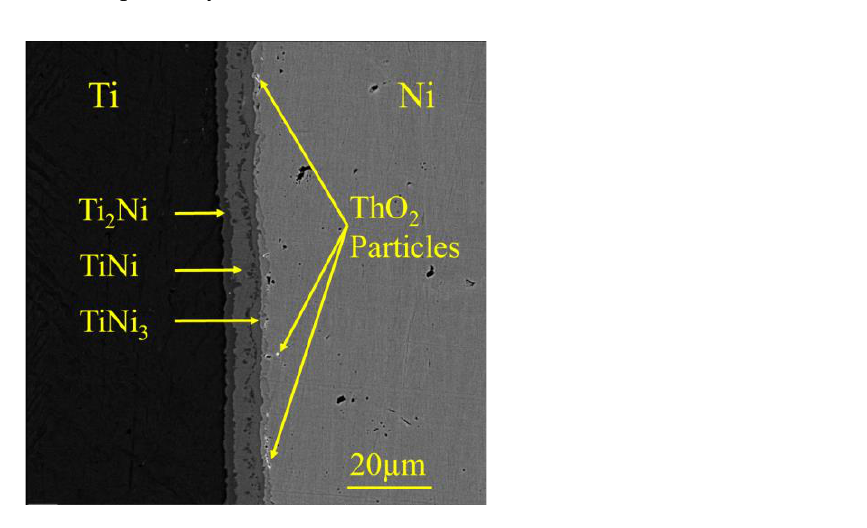
Figure 2. SEM micrograph at the interface of the Ti – Ni diffusion couple. To study the diffusion behavior, ThO 2 particles were placed at the Ti – Ni interface. The sample was annealed at 1173 K for 5 h.